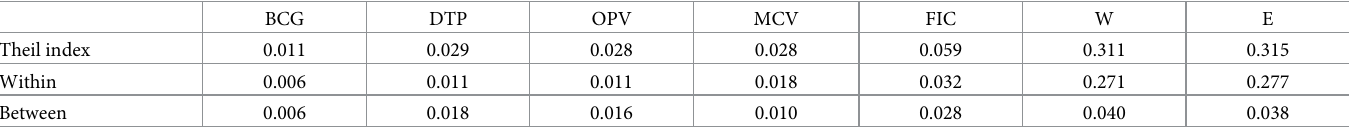
Table 2. Theil indices and their components for coverage of BCG vaccine, DTP vaccine, OPV, MCV, FIC, Wagstaff’s (W), and Erreygers’ (E) indices of inequality. Results for individual countries are available in S6 Table. BCG